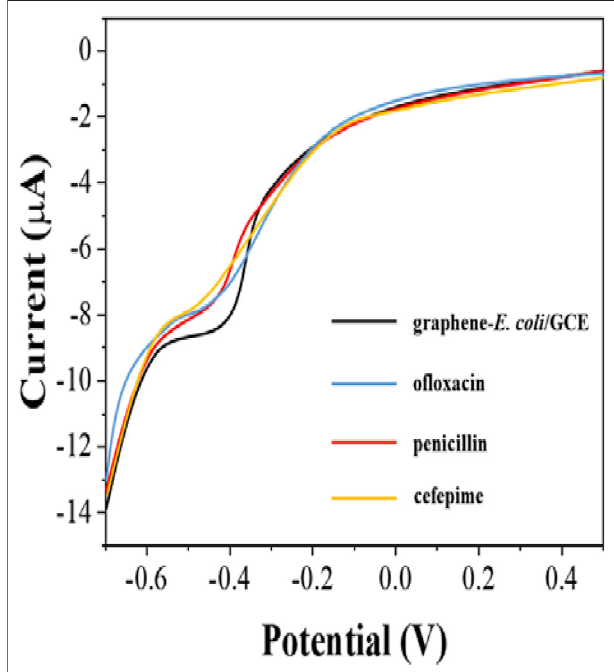
FIGURE 5 | DPV curves of graphene- E. coli /GCE before and after addition of o fl oxacin, penicillin and cefepime at PBS.